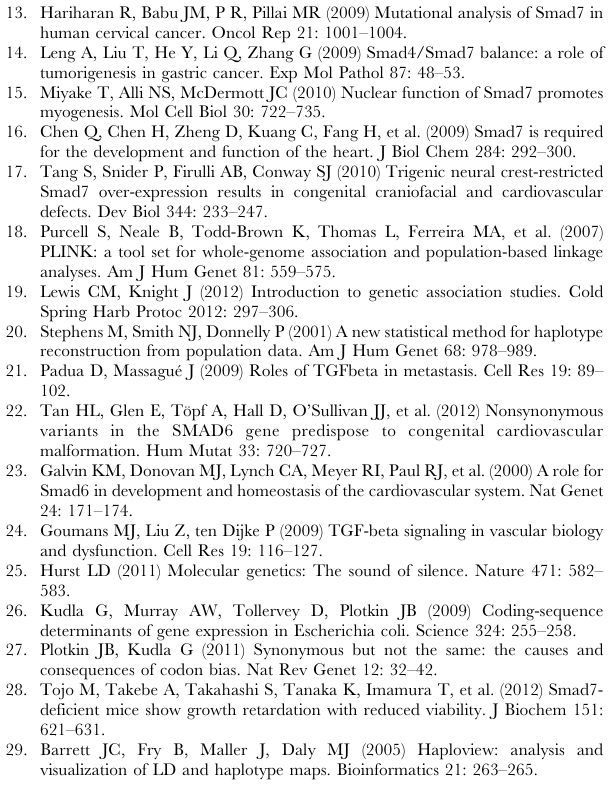
Table S1 Phenotypes of screened population with CHD. Table S2 SMAD7 primers used in PCR amplification. Table S3 Genotype frequencies of SMAD7 rs3809922 and rs3809923 in 1,201 CHD patients and 1,116